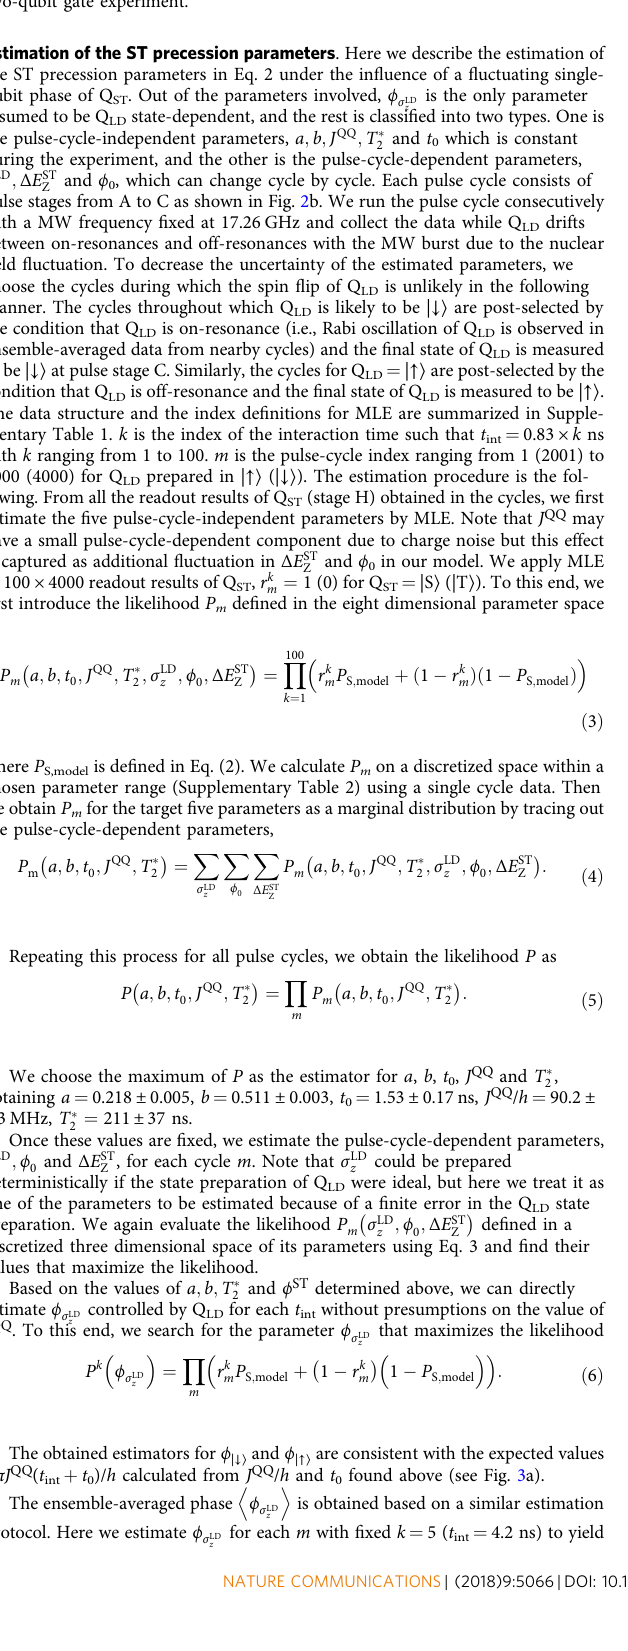
then take the average of the estimated values for 800 pulse cycles. The oscillation D E visibility of ϕ σ LD in Fig. 4b is limited by three factors, low preparation fi delity of z the input Q LD state, estimation error of ϕ σ LD and CPHASE gate error. The fi rst z contribution is likely to be dominant as the visibility of the oscillation in P ↓ is correspondingly low. Note that the effect of those errors is not visible in Fig. 3 because the most likely values of ϕ σ LD are plotted. z Data availability The data that support the fi ndings of this study are available from the corre- sponding authors upon reasonable